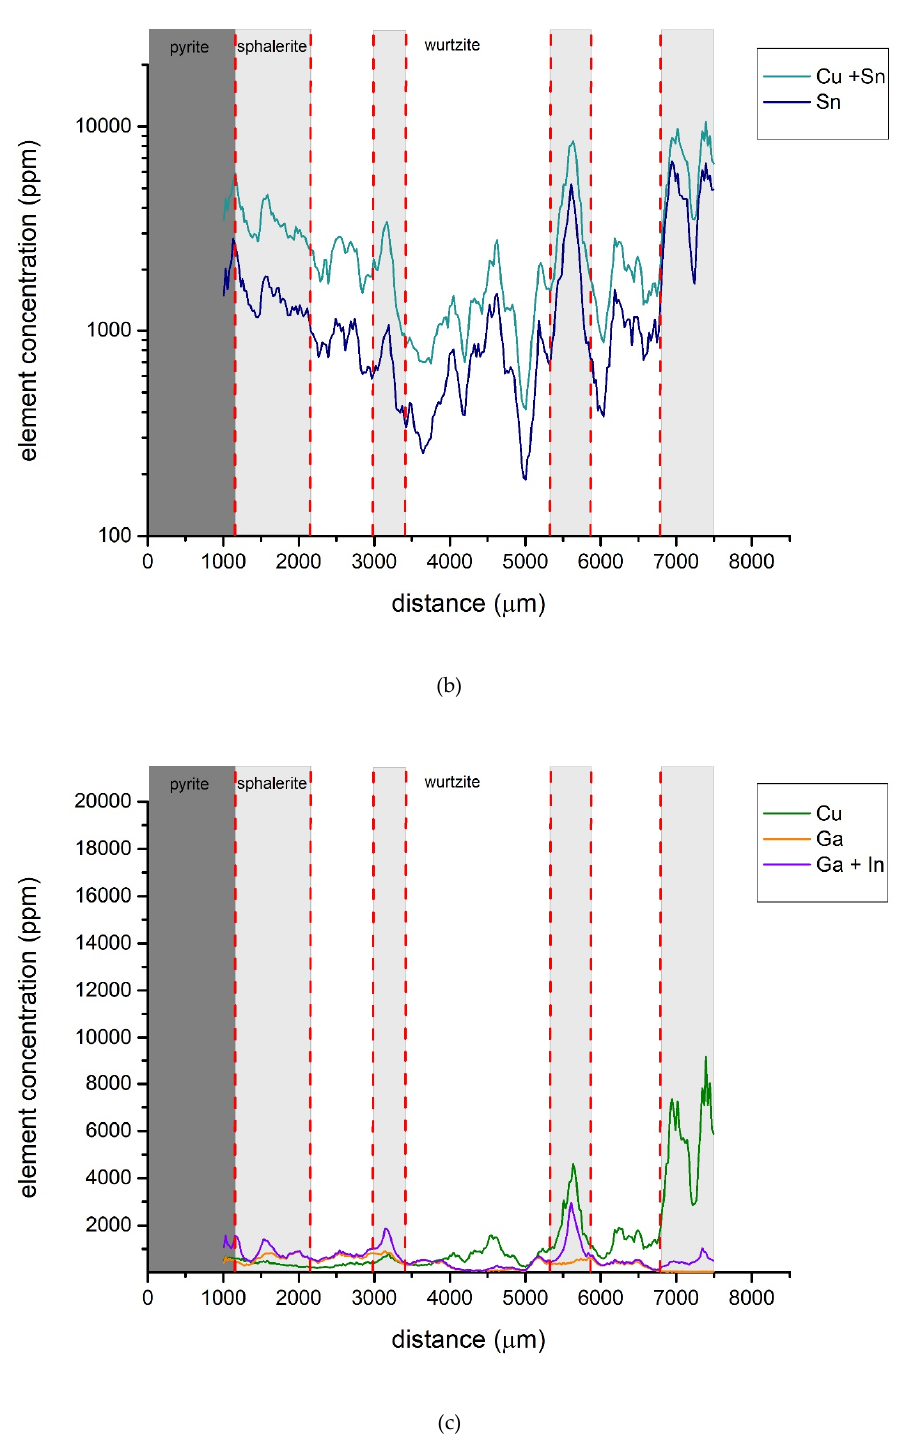
Figure 6. LA-ICP-MS traverses across Animas wurtzite-sphalerite sample. ( a ) traverse showing the partial coupling of the 2Ag + + Sn 4+ ↔ 3Zn 2+ substitution, which breaks down about 4000 µm from the bottom (pyrite) of the sample. ( b ) The traverse showing the 2(Ag + Cu) + Sn ↔ 3Zn substitution across the sample. ( c ) traverse showing the lack of coupling between Cu, and Ga or Cu and Ga + In. + + + ↔ + A well-documented coupled substitution in ZnS is the Cu Ga 3 2 Zn 2 substitution. This is observed in the Merelani sample across both the wurtzite and sphalerite regions (Figure 5b). The Cu and Ga levels are around 1200 ppm in the wurtzite region and increase to over 1800 ppm in the sphalerite zone. This coupled substitution does not, however, hold in the Animas sample. In the